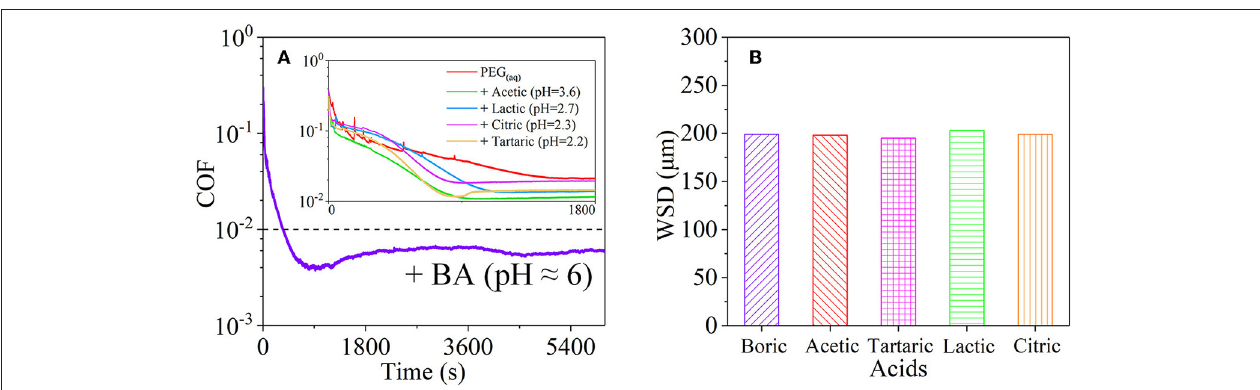
FIGURE 7 | COF under lubrication with mixtures of H 2 SO 4 solution and polyhydroxy alcohols (A) with 3 carbon atoms in its carbon chain; (B) with various carbon chain length. The volume ratio of the polyhydroxy alcohols to the H 2 SO 4 solution (pH 1) is 10:1. Li et al. (2013c) Copyright 2013, American Chemical Society.